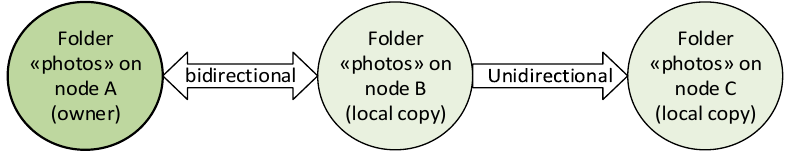
Figure 2. Multilateral synchronization by extension from a paired node.